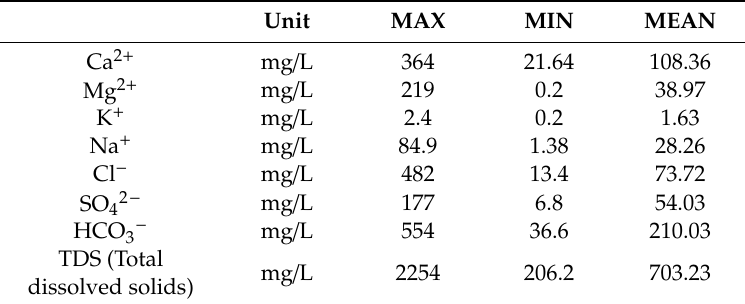
Table 2. Statistical analysis results of water quality